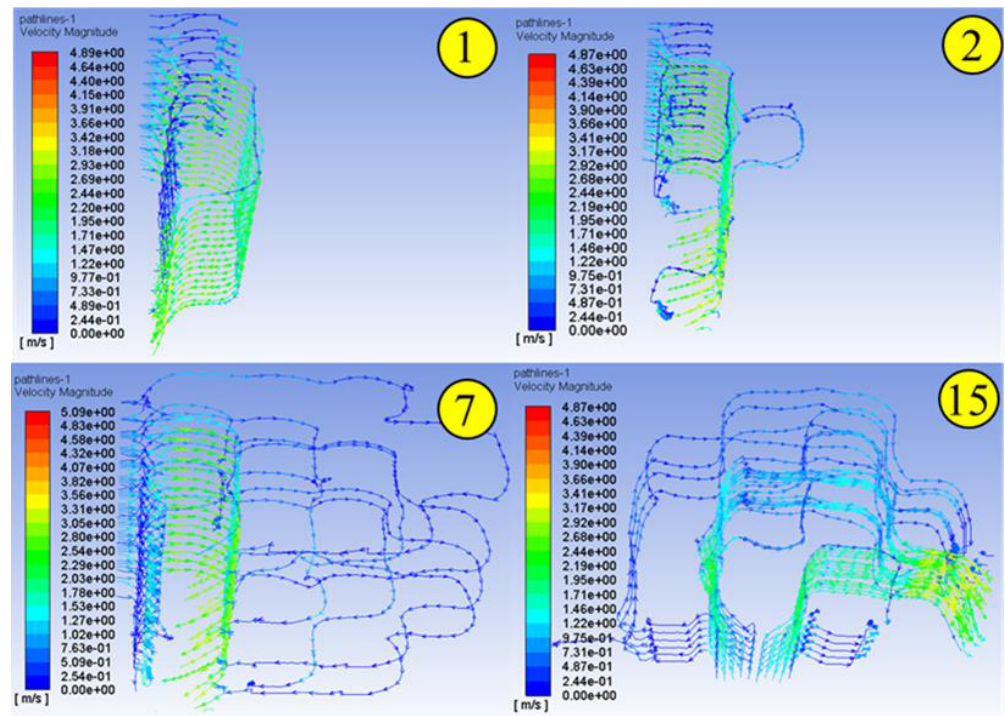
Figure 15. Velocity path line of scheme 1,2,7,15.